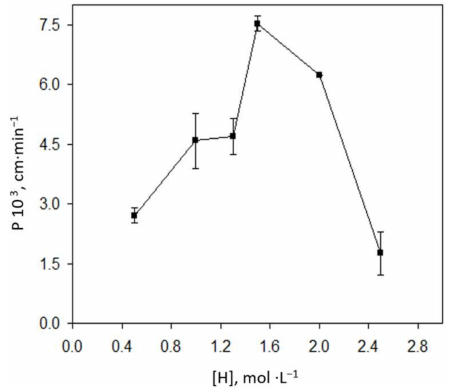
Figure 2. Effect of the hydrochloric acid concentration in the receiving solution on the